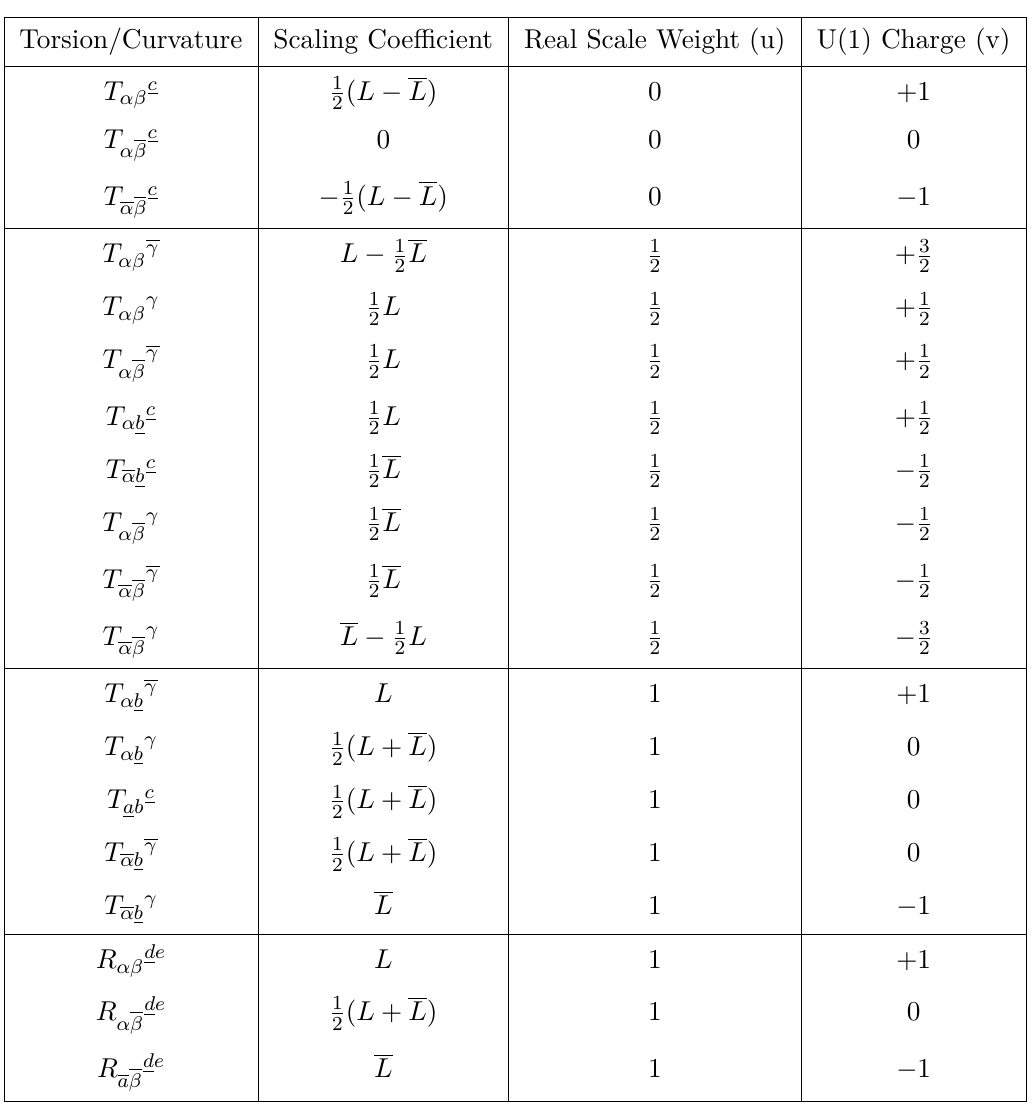
Table 1 . Summary of Weyl complex scaling properties of 10D, N = 2B torsions and curvatures. complex and thus we have two degrees of freedom. The J -tensors are defined